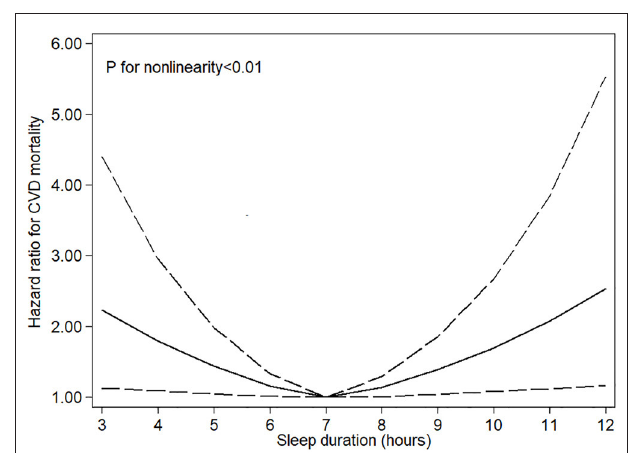
FIGURE 2 | Restricted cubic spline models for sleep duration and risk of cardiovascular mortality. Knots were placed at the 10th, 50th, and 90th percentiles of sleep duration. Results were adjusted for age, sex, race/ethnicity, education, physical activity, drinking and smoking status, HEI − 2015 scores, body mass index, family history of diabetes mellitus and heart disease, history of diabetes, heart disease, and